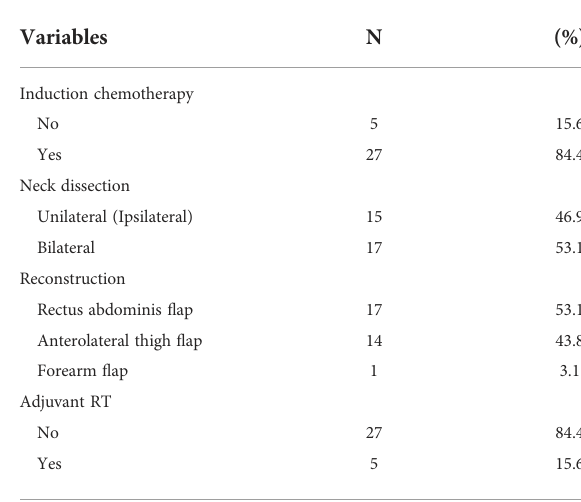
TABLE 1 Patient characteristics (N =